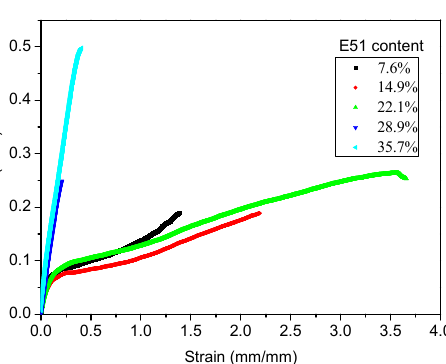
Figure 8. Mean stress-strain curve of epoxy modified silicone coatings.